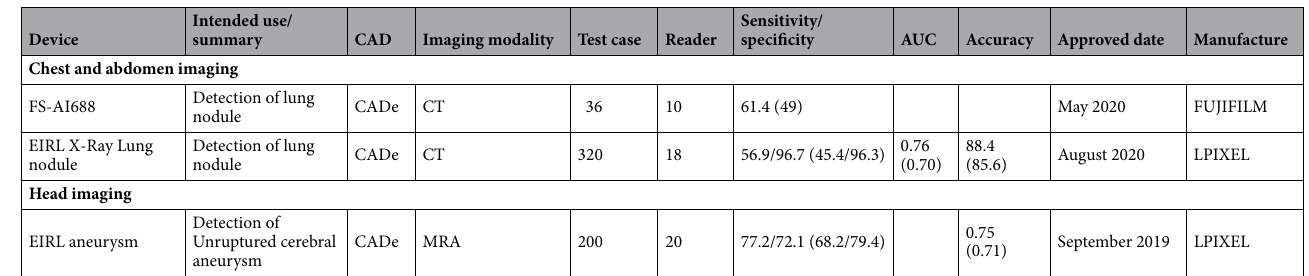
Table 4. Characteristics of the 3 PMDA approved AI/ML-based CAD evaluated by Reader Study Testing. Sensitivity/specificity and AUC are shown as with AI (without